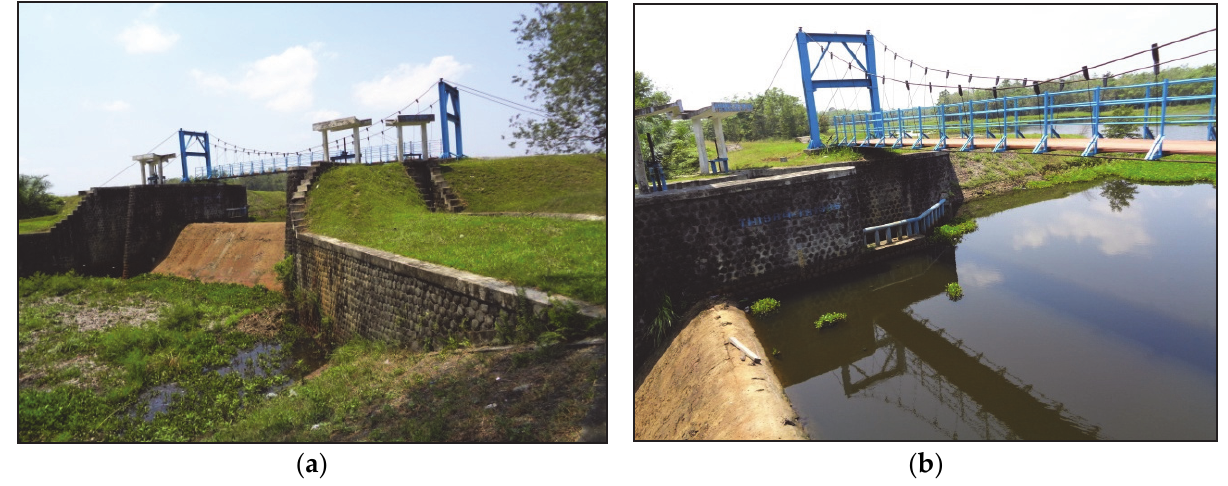
Figure 4. ( a ) Downstream and water level of Moyan weir; ( b ) upstream of Moyan